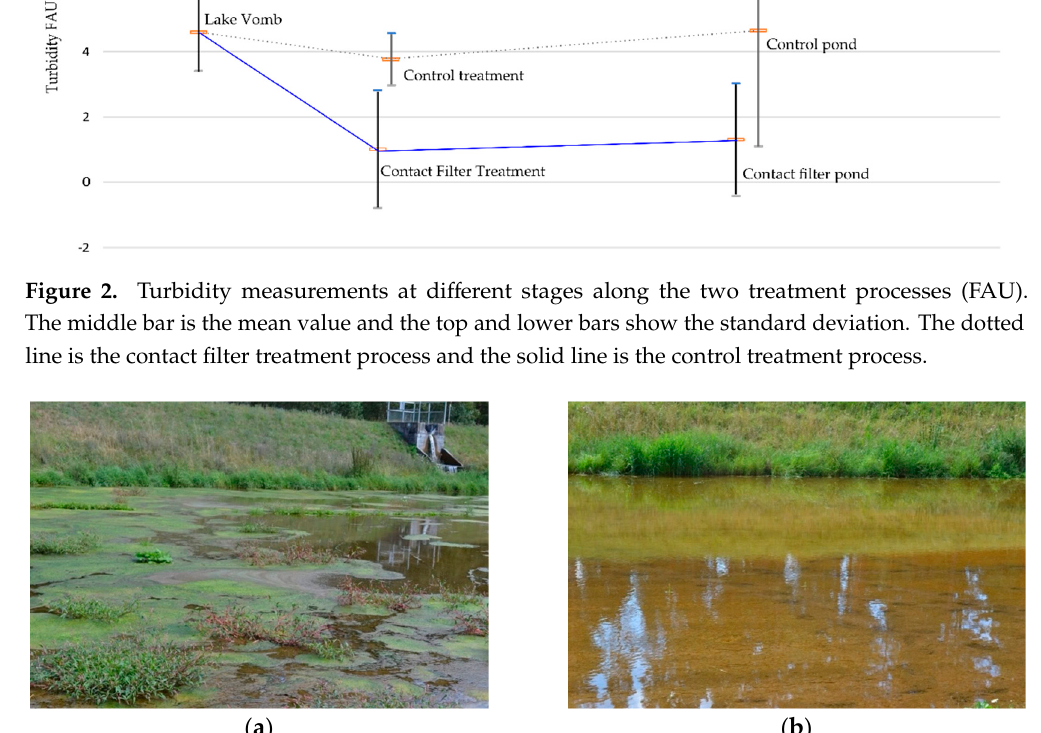
Figure 3. Onsite observation of two sides of pond in August 2014: ( a ) control pond and ( b ) contact filter pond (photo taken by Marie Baehr and Petra Larsson).